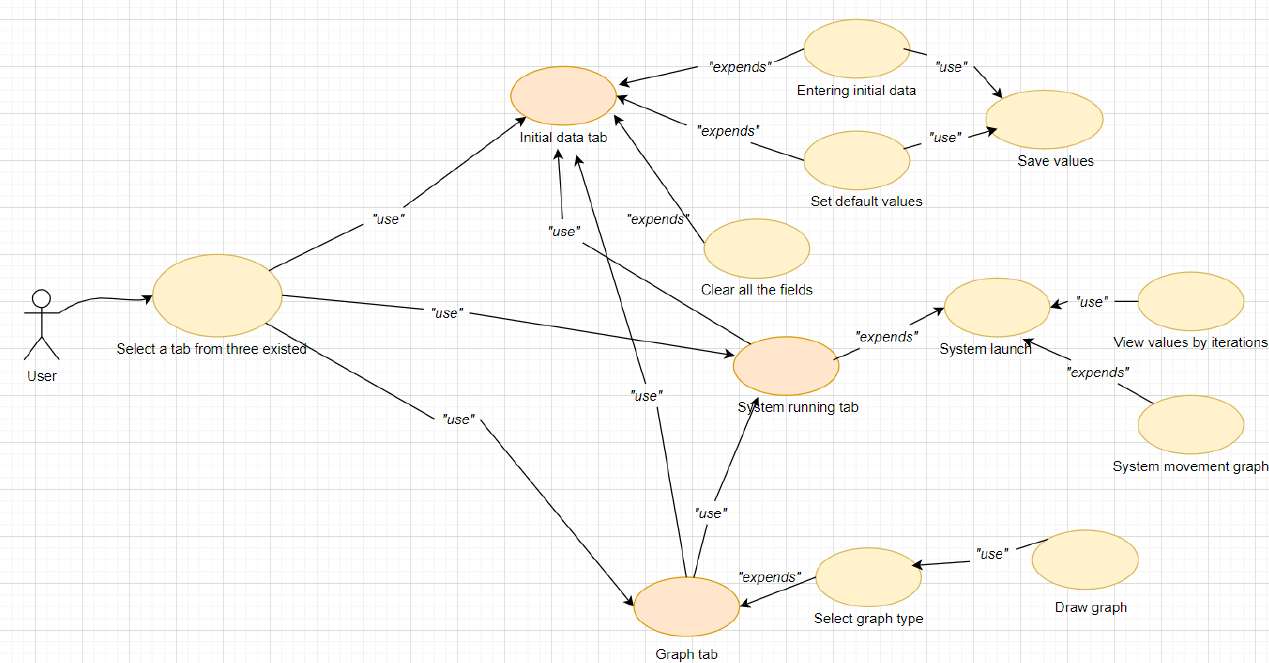
Figure 5. Use cases diagram.